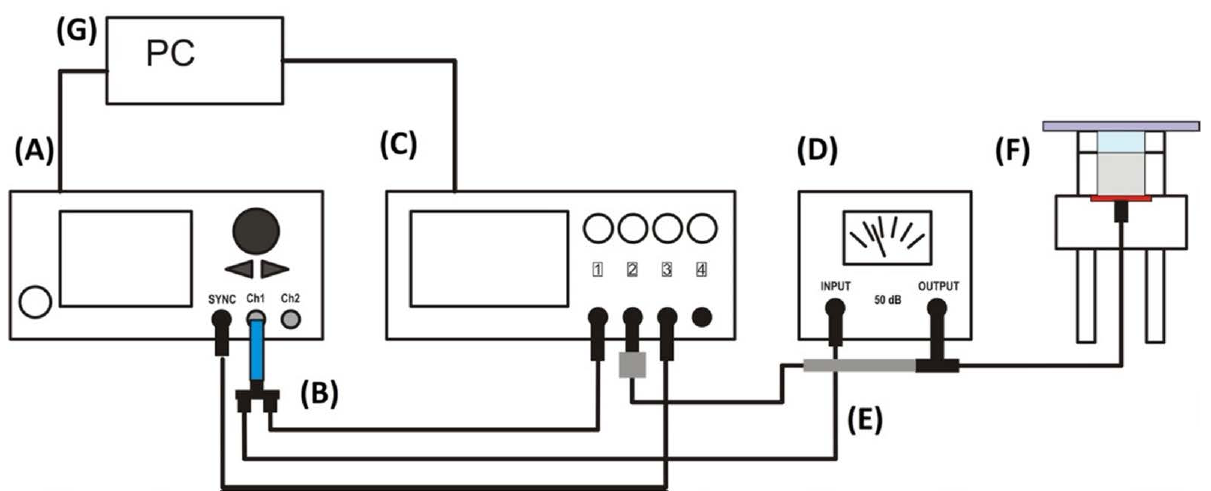
Figure 8. Schematic representation of the transmission voltage measurements in the TEA set-up: function generator ( A ), 15dB attenuator ( B ), oscilloscope ( C ), amplifier ( D ), oscilloscope probe ( E ), TEA set-up ( F ), and computer with software ( G